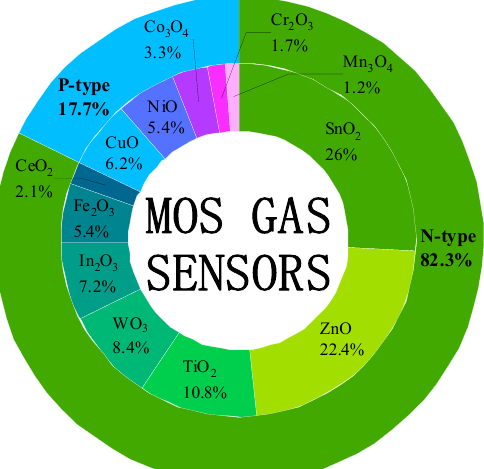
Figure 5 . Publication of papers and patents on major MOS gas sensors before 15 February 2023. Here, the papers and patents were searched on the Web of Science, refined by ‘keywords = gas sensor, the chemical formula and the scientific name of the sensor material’ with all document types on 15 February